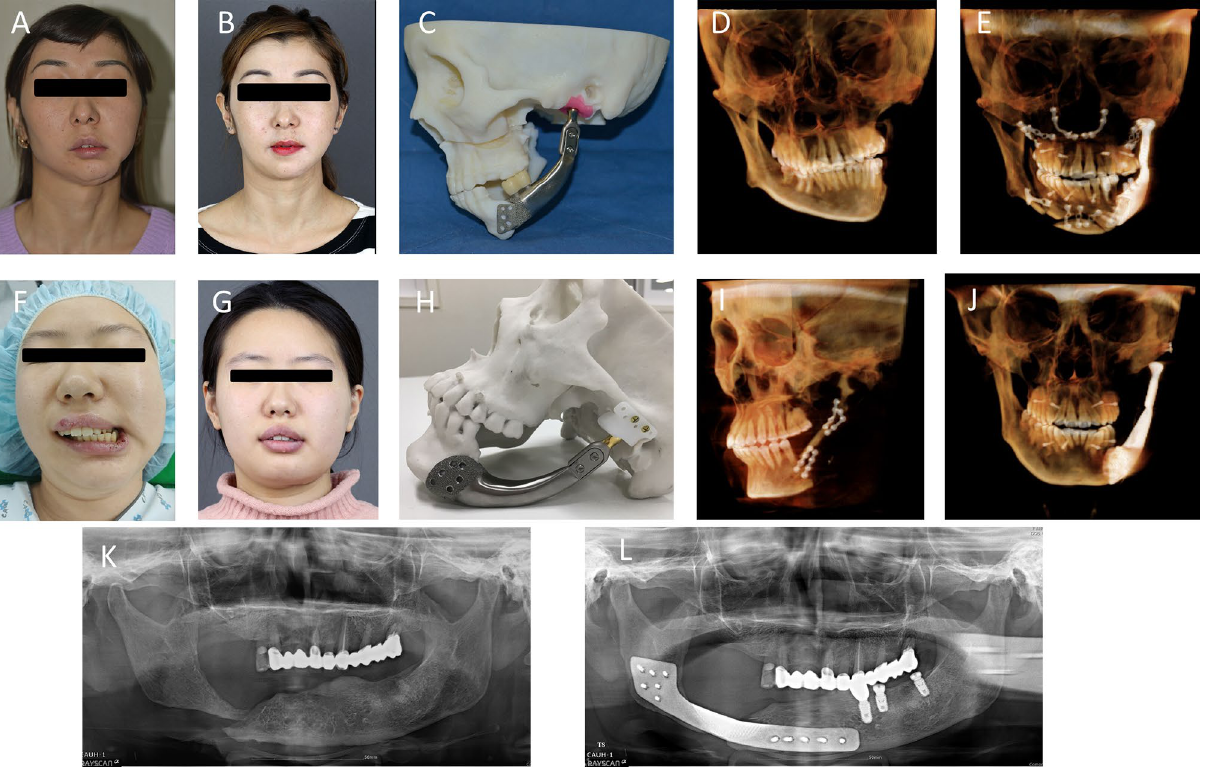
Figure 1. Titanium reconstruction of tumor-induced mandibular defects. ( A ) A 25-year-old female patient was referred for the reconstruction of the left mandible and correction of facial asymmetry; ( B ) Postoperative photograph of the female patient. ( C ) A titanium three-dimensional (3D)-printed mandible was fabricated. The two abutments that faced the central fossa of the maxillary molar were designed for prosthetic restoration. Temporary crowns were also 3D-printed. ( D , E ) Preoperative and postoperative 3D reconstructed cone- beam computed tomography (CBCT) images. Reproduced from Lee UL et al. J Oral Maxillofac Surg. 2016 Jul;74(7):1501.e1-1501.e15, with permission of Elsevier Inc. ( F ) A 26-year-old female patient whose mandible was deviated to the left side by more than 10 cm. ( G ) Postoperative facial photograph shows that the face is symmetric, and the mandible is no longer shifted to left. ( H ) To overcome these problems, a titanium 3D-printed mandible was fabricated by Medyssey Inc. The Korean Food and Drug Administration does not approve patient-specific joints as of now. Hence, we connected a prefabricated temporomandibular joint to a 3D-printed mandible. ( I , J ) Preoperative and postoperative 3D reconstructed CBCT images. ( K ) A 78-year- old-female patient had a right segmental mandibular defect after a mandibulectomy due to malignancy; ( L ) the mandible was successfully reconstructed with a titanium 3D-printed